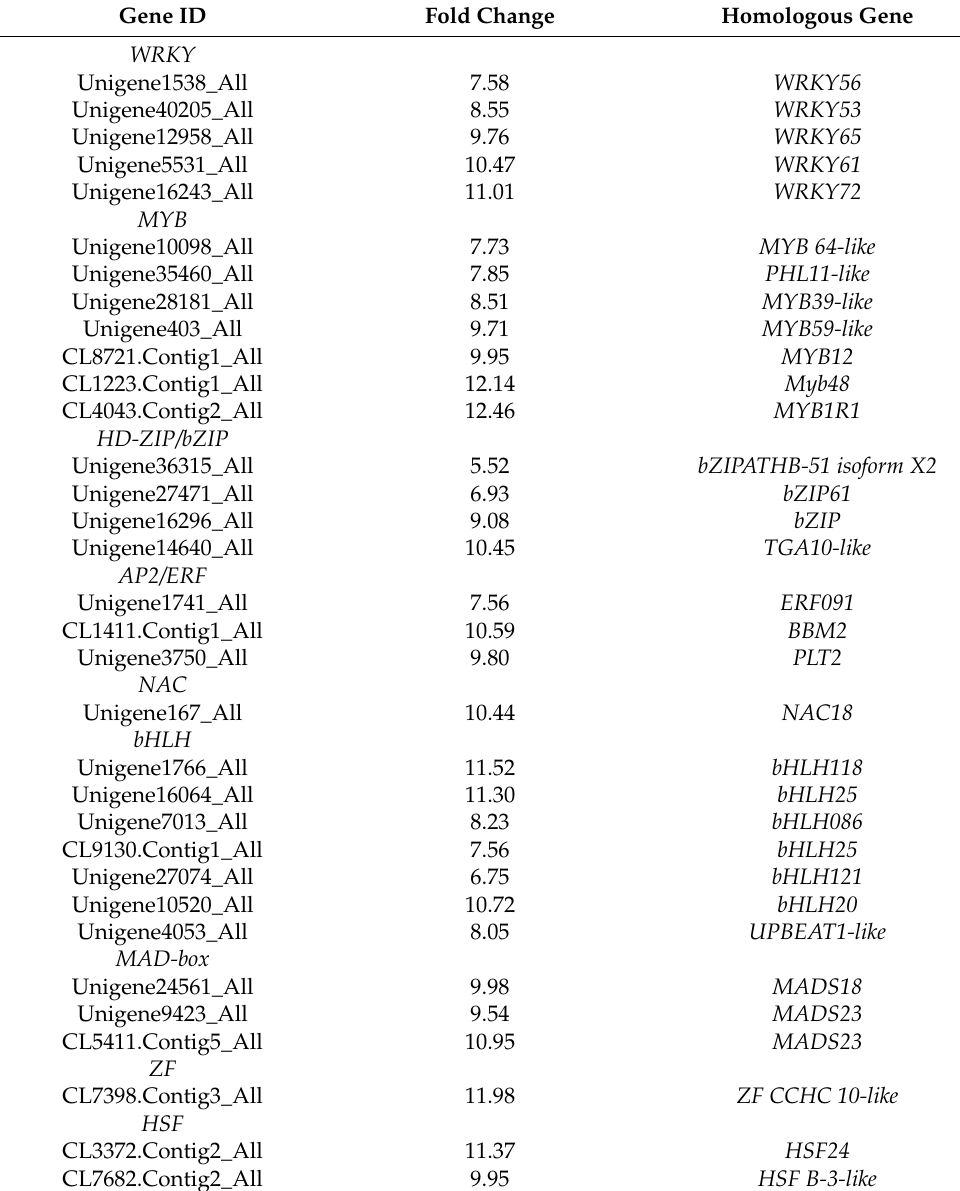
Table 11. The upregulated DEGs related to the transcription factors in the leaves of A. canescens under 100 mM NaCl, but not under control conditions, for 6 h.